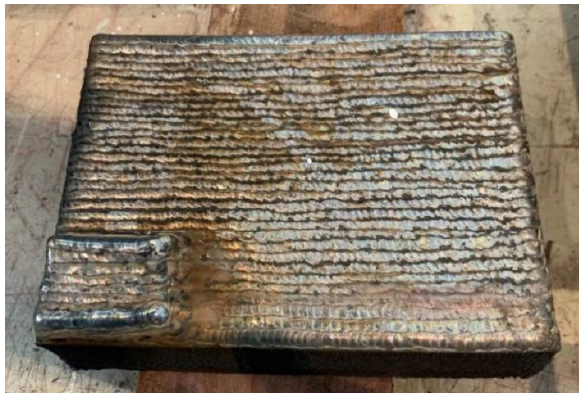
Figure 2. Plain plate welded by manual TIG welding technique. Table 4. The first-round TIG welding